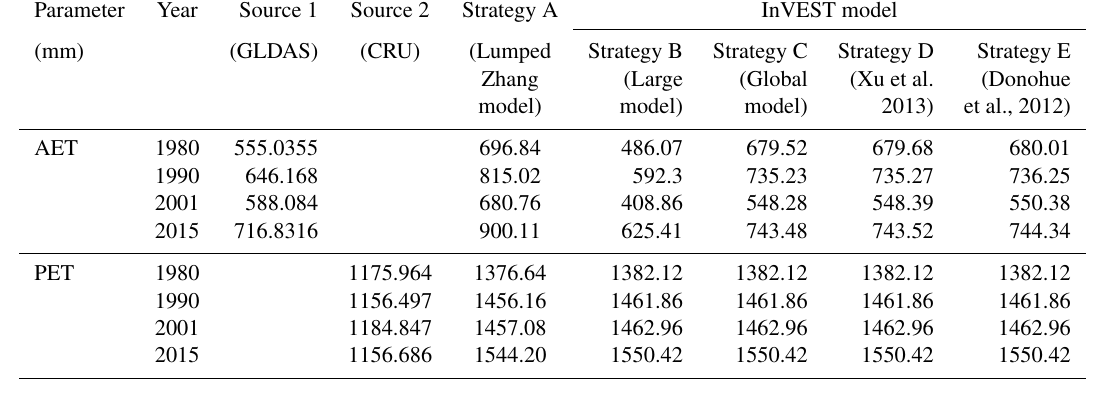
Table 2. Comparison of model-estimated PET and AET with a global dataset from different sources.